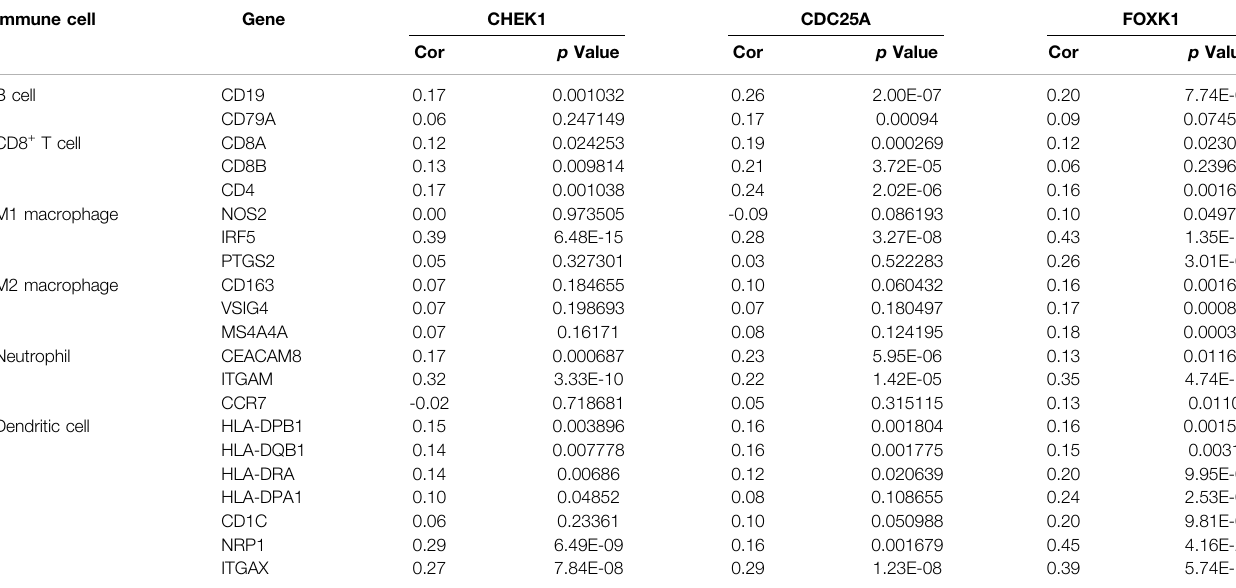
FIGURE 9 | Associations of the expression of CHEK1 (A) , CDC25A (B) , FOXK1 (C) in the ceRNA network with immune in fi ltration levels in LIHC.